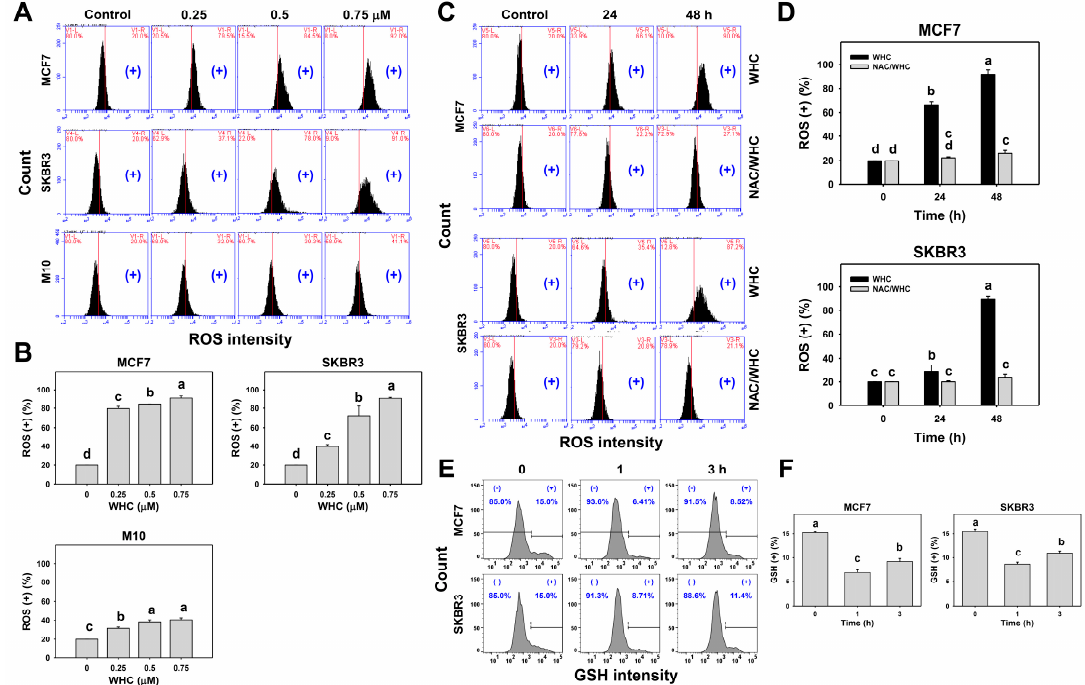
Figure 4. WHC di ff erentially induced reactive oxygen species (ROS) generation among breast cancer and normal breast cells. ( A , B ) ROS profiles and statistics for dose e ff ects to WHC. Breast cancer (MCF7 and SKBR3) cells and normal breast (M10) cells were treated with WHC (control (0.075% DMSO), 0.25, 0.5, and 0.75 µ M) for 48 h. ( + ) located at the right side of each profile is counted for ROS ( + ) (%). ( C , D ) NAC pretreatment reversed the WHC induced ROS generation. Following pretreatments with NAC (10 mM for 1 h), cells were treated with control (0.075% DMSO) and 0.75 µ M of WHC for 0, 24, and 48 h, i.e., NAC / WHC. ( E , F ) GSH profiles and statistics for time course changes to WHC. Breast cancer MCF7 and SKBR3 cells were treated with WHC (control (0.075% DMSO) and 0.75 µ M) for 0, 1, and 3 h. ( + ) located at right side of each profile is counted for GSH ( + ) (%). Data, means ± SDs ( n = 3). Results marked without overlapping letters show significant di ff erences ( p < 0.05 to 0.0001).